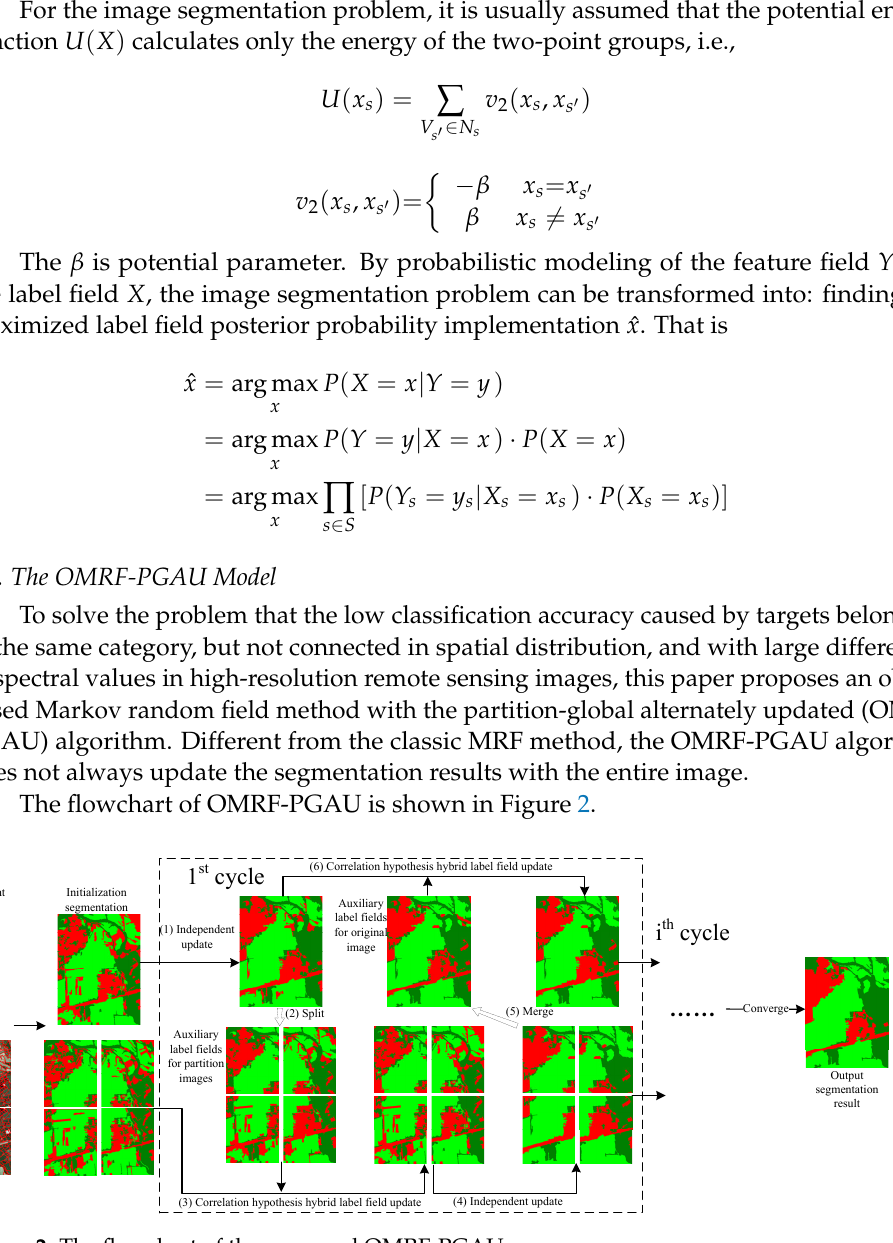
ages. Then the RAG, G = ( V , E ) for the original image I , and G (cid:48) = (cid:16) (cid:17) G ( i ) = V ( i ) , E ( i ) for the partitioned images I (cid:48) are established, respectively, and the feature (cid:110) Y ( 1 ) , Y ( 2 ) , Y ( 3 ) , Y ( 4 ) field Y , Y (cid:48) =